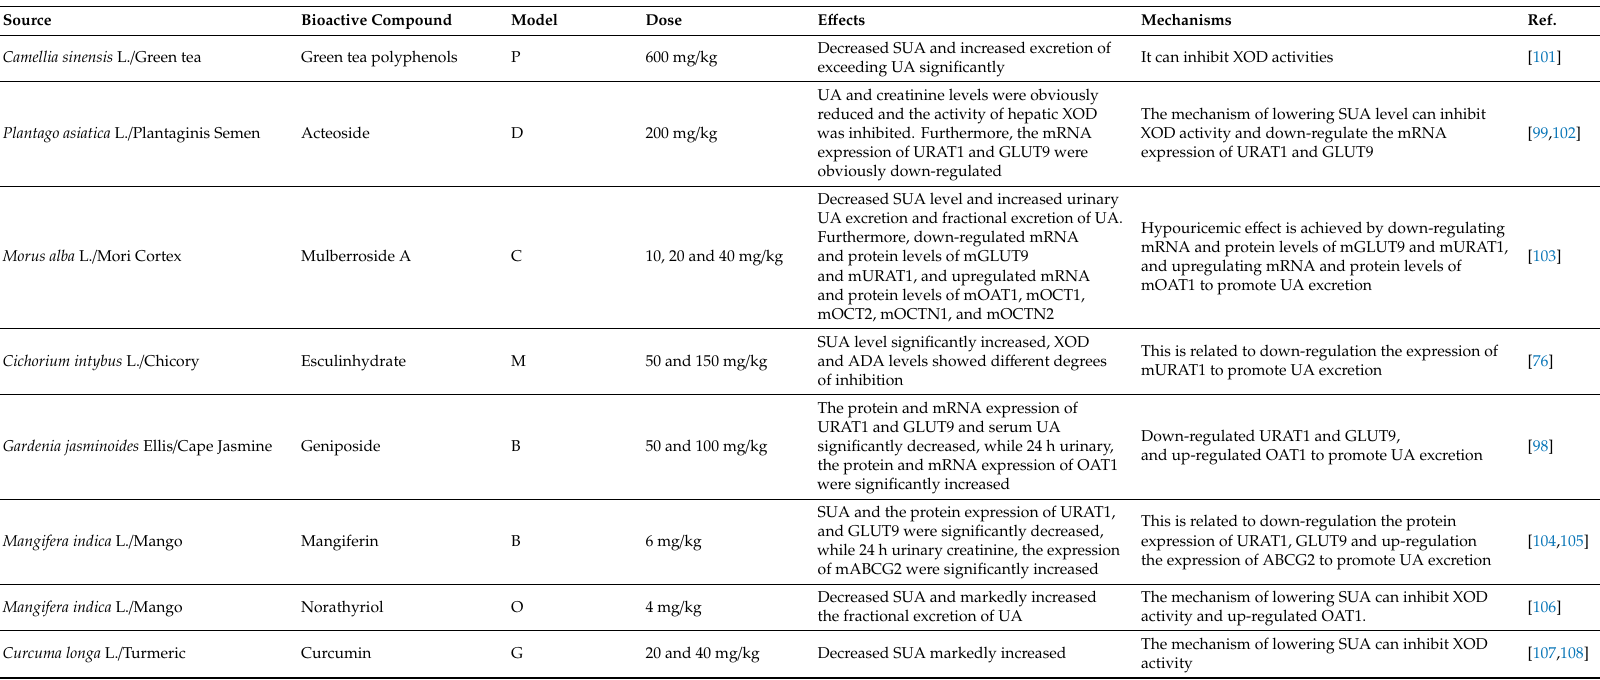
Table 6. Experiment and mechanism of other bioactive components from plant-based functional foods on